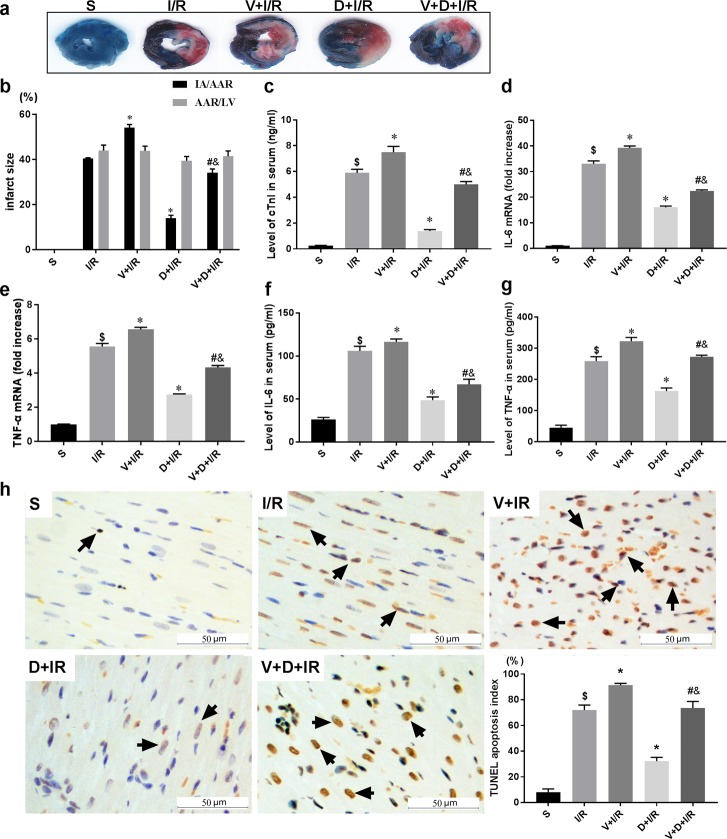
The vagal nerve mediates DEX-induced short-term cardioprotection against I/R.Unilateral vagotomy or sham operation was induced before DEX or saline pretreatment followed by myocardial I/R. The extent of myocardial injury was evaluated by infarct size using Evans blue/TTC staining (a-b), serum levels of cTnI (c), and myocardial expression of IL-6 and TNF-α (d-e). Serum levels of IL-6 and TNF-α were also measured by ELISA (f-g). Myocardial apoptosis in infarct zone was evaluated by TUNEL staining (h). Representative pictures for each group as well as the corresponding quantitative analysis using the TUNEL apoptosis index (TUNEL-positive cell numbers /total cell numbers ×100%) were shown; arrows indicate positive cells, Scale bar = 50μm. Data shown are mean ± SEM; n = 10 per group; $ p<0.05 vs. S; *p < 0.05 vs. I/R; #p < 0.05 vs. D+I/R; &p < 0.05 vs. V+I/R. All specimen were obtained at the timepoint of myocardial I/R for 2hrs. S: sham operation; I/R: myocardial ischemia-reperfusion; D: dexmedetomidine; V: vagotomy;